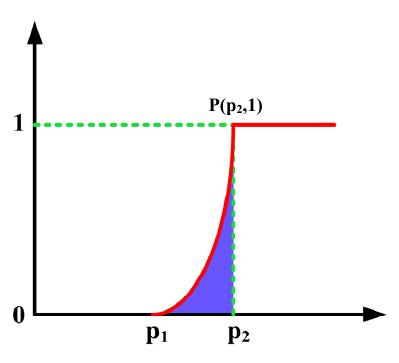
Figure A3. The De-Blurring control result for high membership function in the CMFI system.